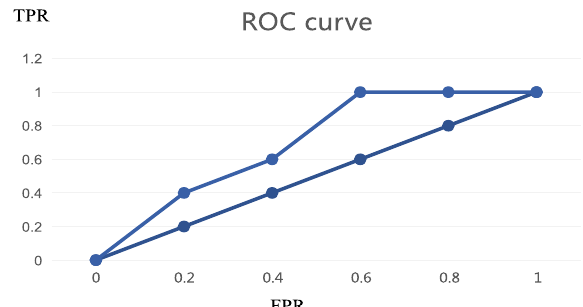
Fig. 9 ROC curve of our proposed